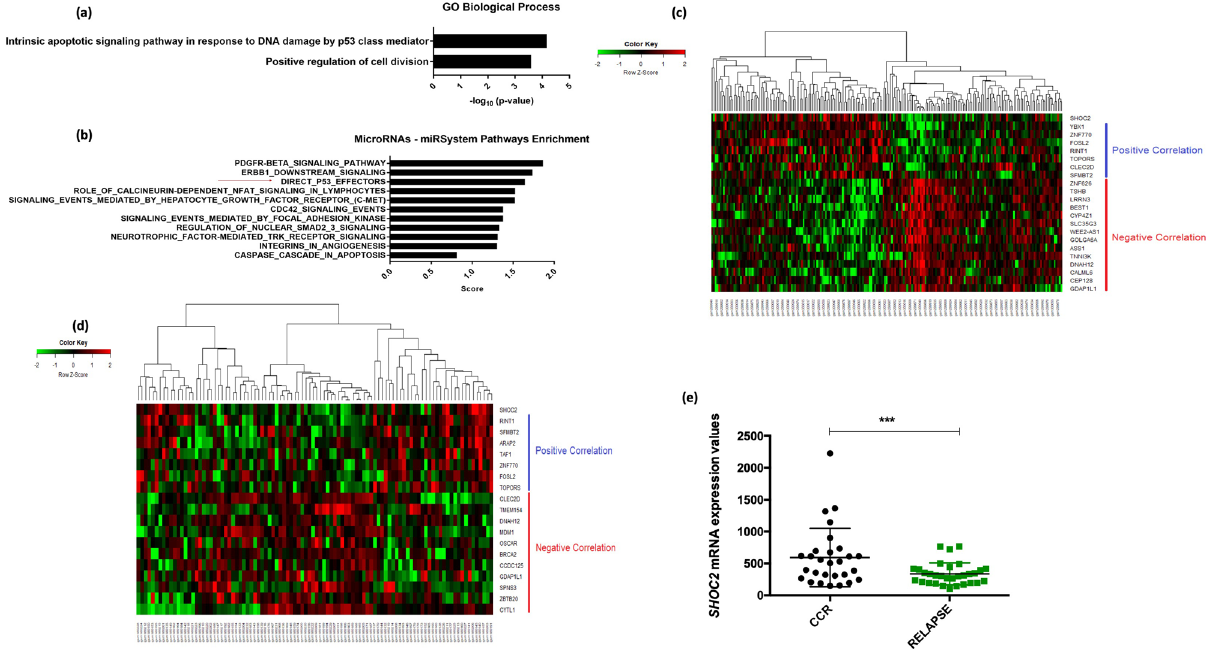
Figure 1. ( a ) Reh cells transcriptome profile. Enriched Gene ontology (GO) biological processes of the differentially expressed mRNA transcripts (Fold change > 5.0) between control (SCR) and SHOC2